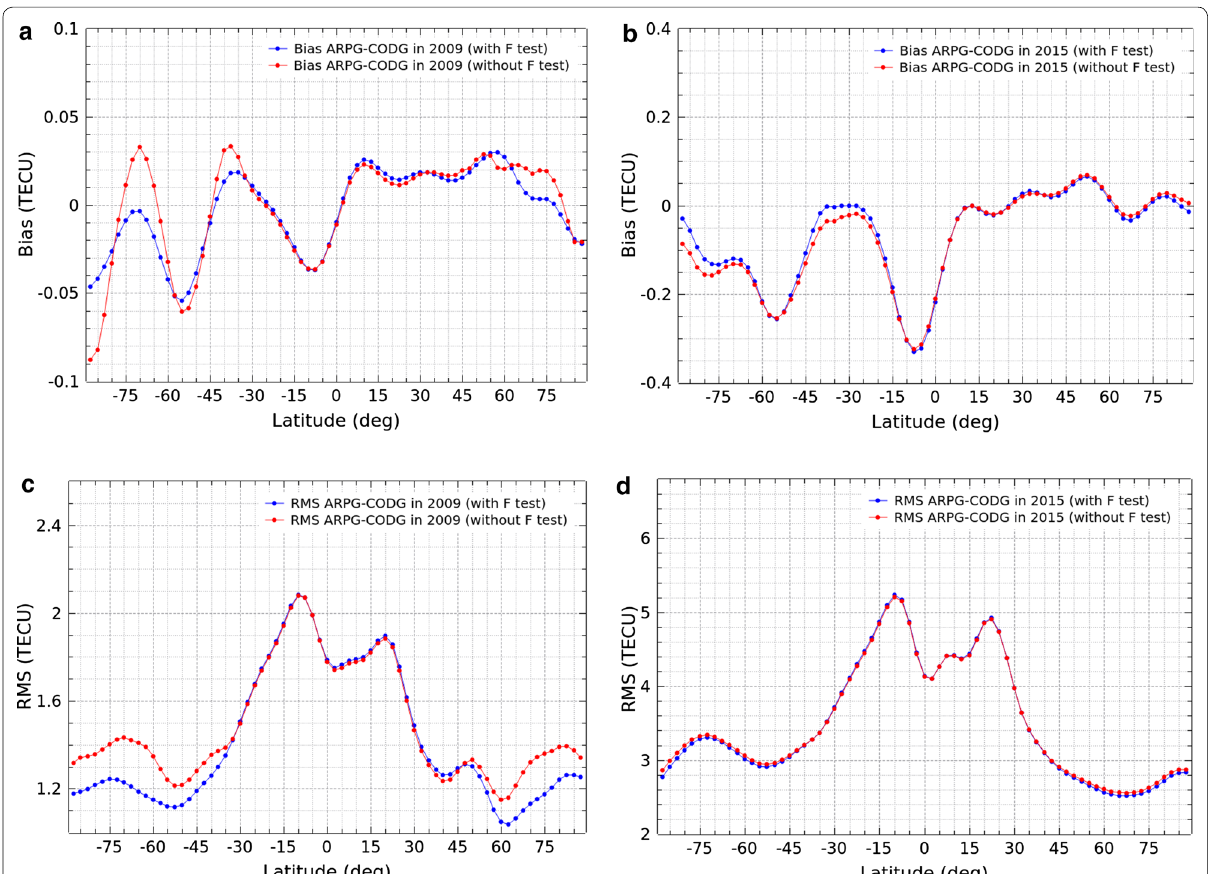
Fig. 7 Bias and RMS of the differences between forecasting products ARPG and the final CODG in 2009 and 2015. The blue and red dotted lines depict the differences between ARPG with and without an F test and CODG, respectively. a Bias of ARPG minus CODG in 2009. b Bias of ARPG minus CODG in 2015. c RMS of ARPG minus CODG in 2009. d RMS of ARPG minus CODG in